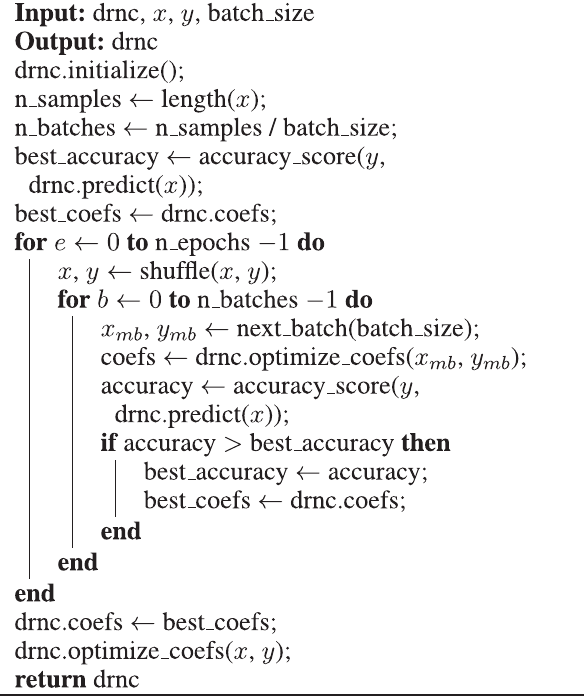
Algorithm 1. Deep Rule Network Training, fi t()-method